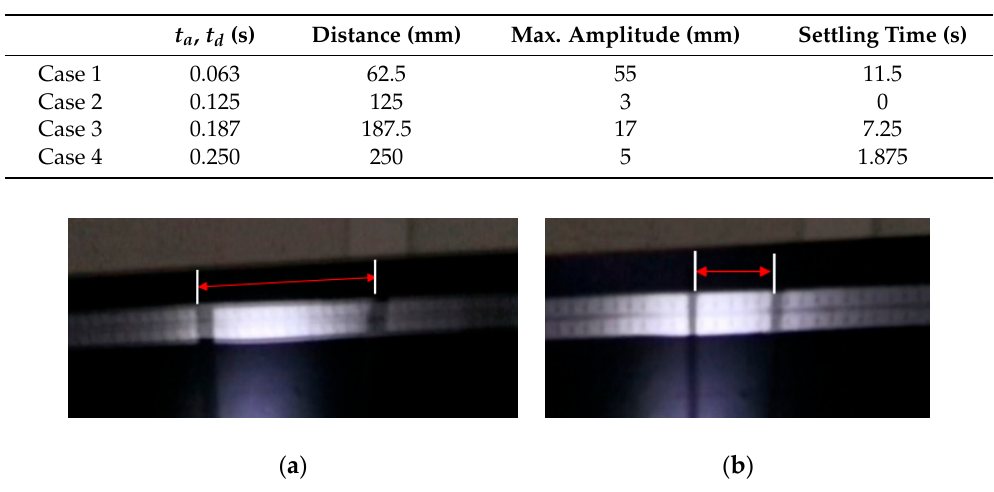
Figure 15 Position deviations at target: ( a ) when 𝑡 (cid:3028) = 0.063 ; ( b ) when 𝑡 (cid:3028) = 0.250 . Figure 15. Position deviations at target: ( a ) when t a = 0.063; ( b ) when t a =